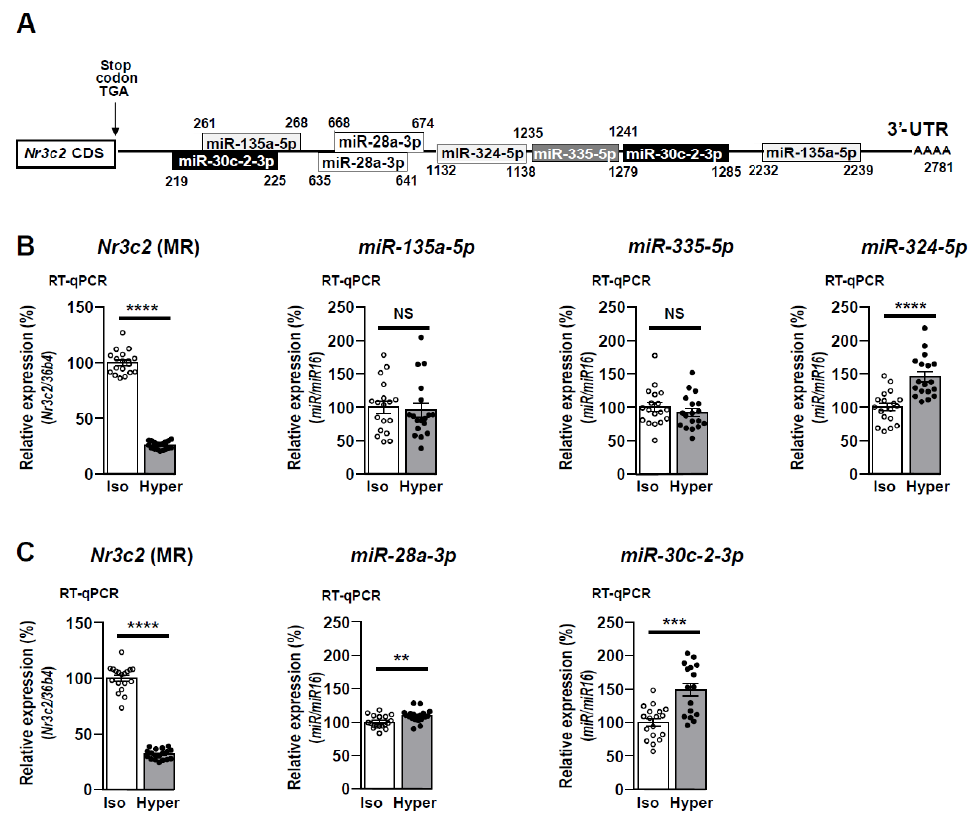
Figure 1. Schematic representation of Nr3c2 (MR) 3′ -UTR, expression of Nr3c2 (MR) and miRNA candidates in renal KC3AC1 cells under hypertonicity. ( A ) Location of predicted binding sites for miRNAs in the murine Nr3c2 (MR) 3′ -UTR, 2.78 kbp, positioned after the stop codon TGA, arbitrarily set at +1. ( B , C ) RT-qPCR analyses of renal MR and expression of miRNA candidates from TLDA ( B ) and miRNAs-seq ( C ) approaches. KC3AC1 cells were grown for 7 days in complete medium then cells were exposed to isotonicity (Iso) or hypertonicity (Hyper) for 6 h. MR transcript and miRNA levels under hypertonicity are expressed as a percentage of Nr3c2 (MR) mRNA or miRNA levels under isotonicity (arbitrarily set at 100%). Data are means ± SEMs from three independent experiments performed in six replicates ( n = 18); isotonic condition (open circle, o), hypertonic condition (black circle, •). NS = not significant, ** p < 0.01, *** p < 0.001 , **** p < 0.0001.